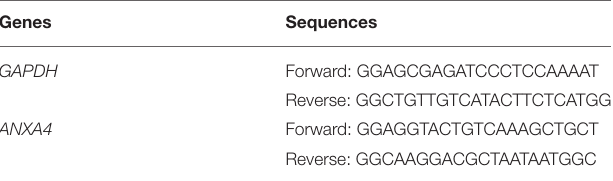
TABLE 1 | Lists of primer sequences used for quantitative real-time